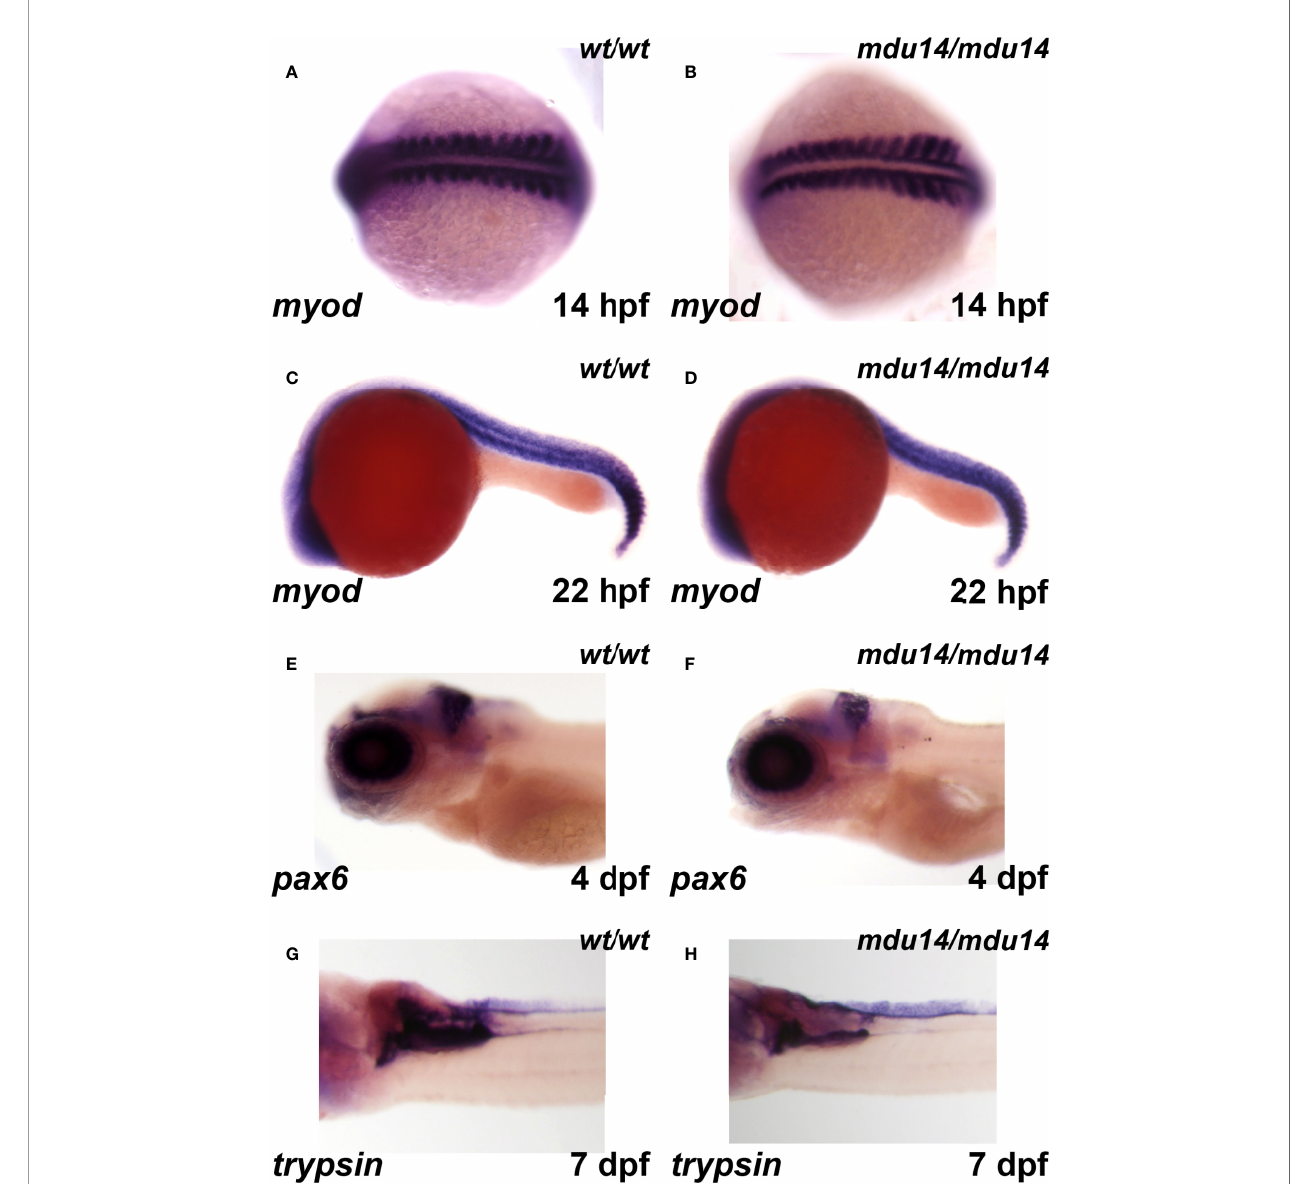
FIGURE 5 | Mutation of crlf3 fails to affect other relevant embryonic tissues. (A – H) Homozygous wild-type crlf3 wt/wt ( wt/wt ), and crlf3 mdu14/mdu14 ( mdu14/mdu14 ) embryos at the indicated ages were subjected to WISH with myod (A – D) , pax6 (E, F) and trypsin (G, H) , presented as dorsal view (A, B) , lateral view (C – F) or ventral view (G, H) with anterior to the left in each